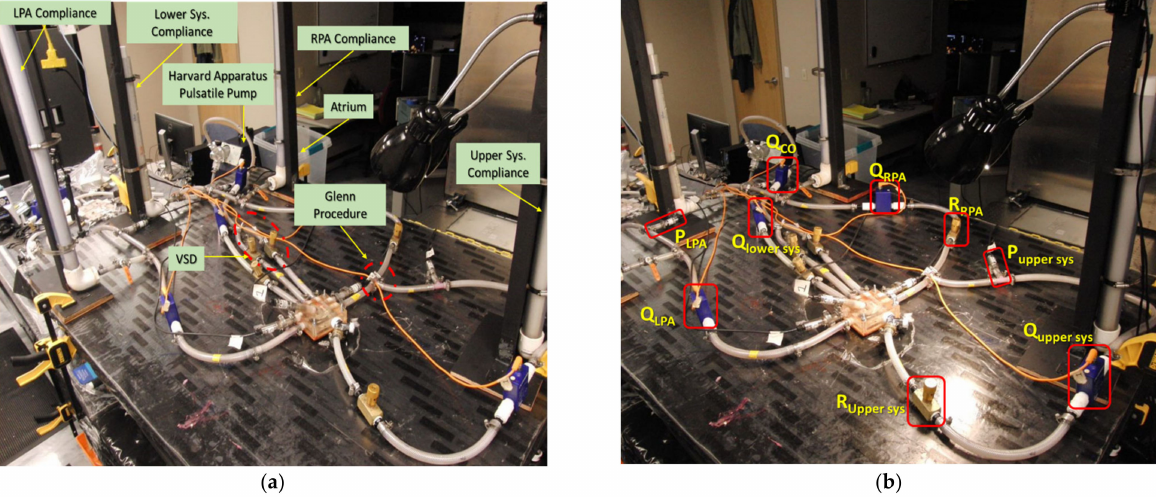
Figure 14. ( a ) MFL set up of HCSII circulation; ( b ) Position of sensing and measuring devices in the MFL